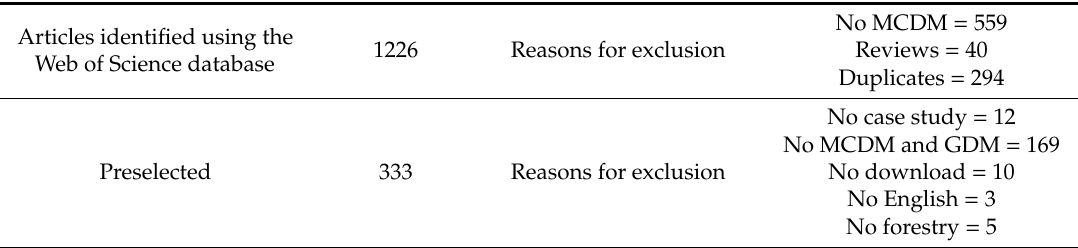
Table 2. Article